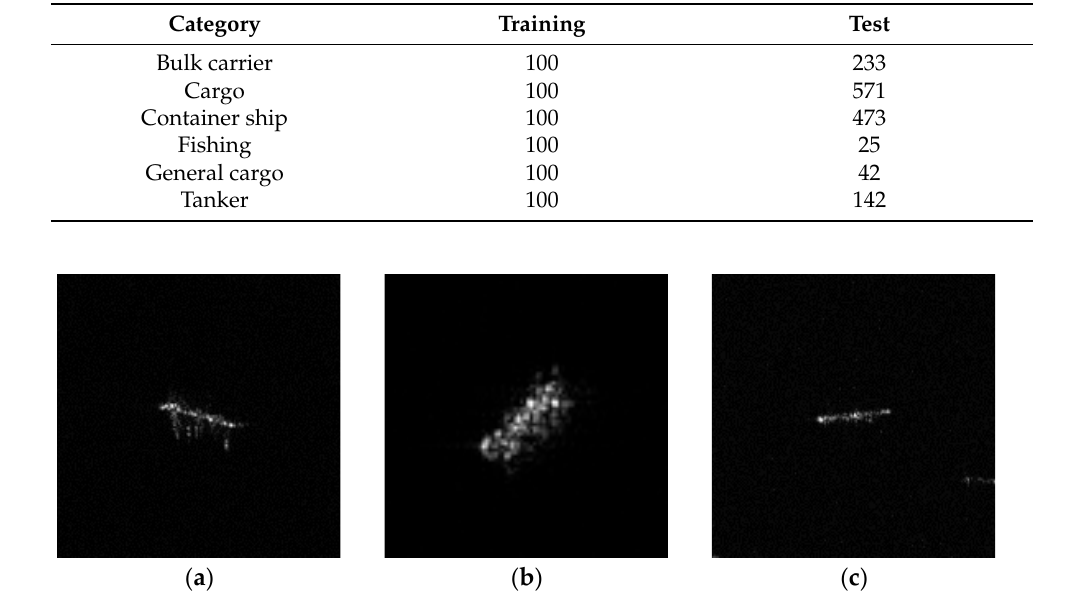
Figure 4. Three-category data. ( a ) Bulk carrier; ( b ) container ship; ( c ) tanker.